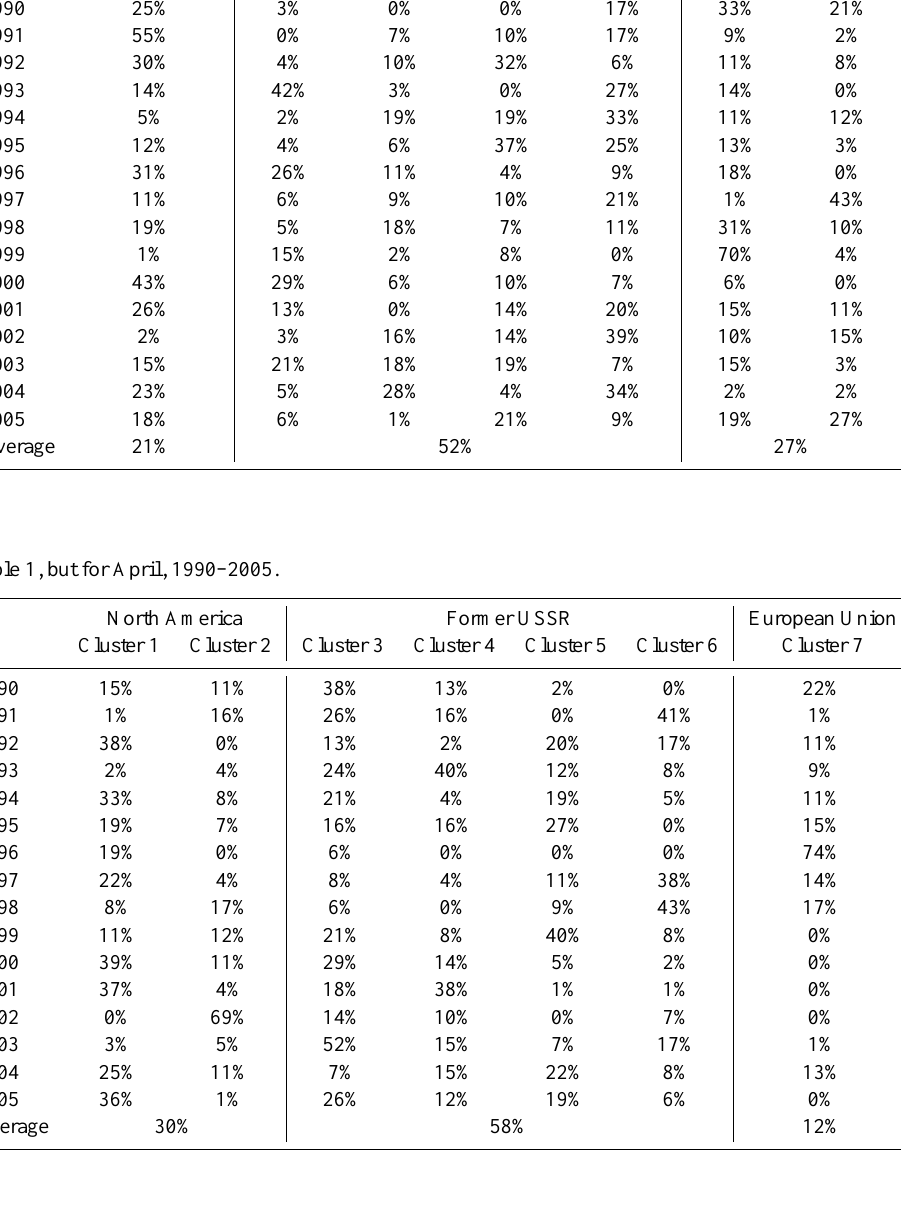
Table 3. Values of b i factors for January and April,